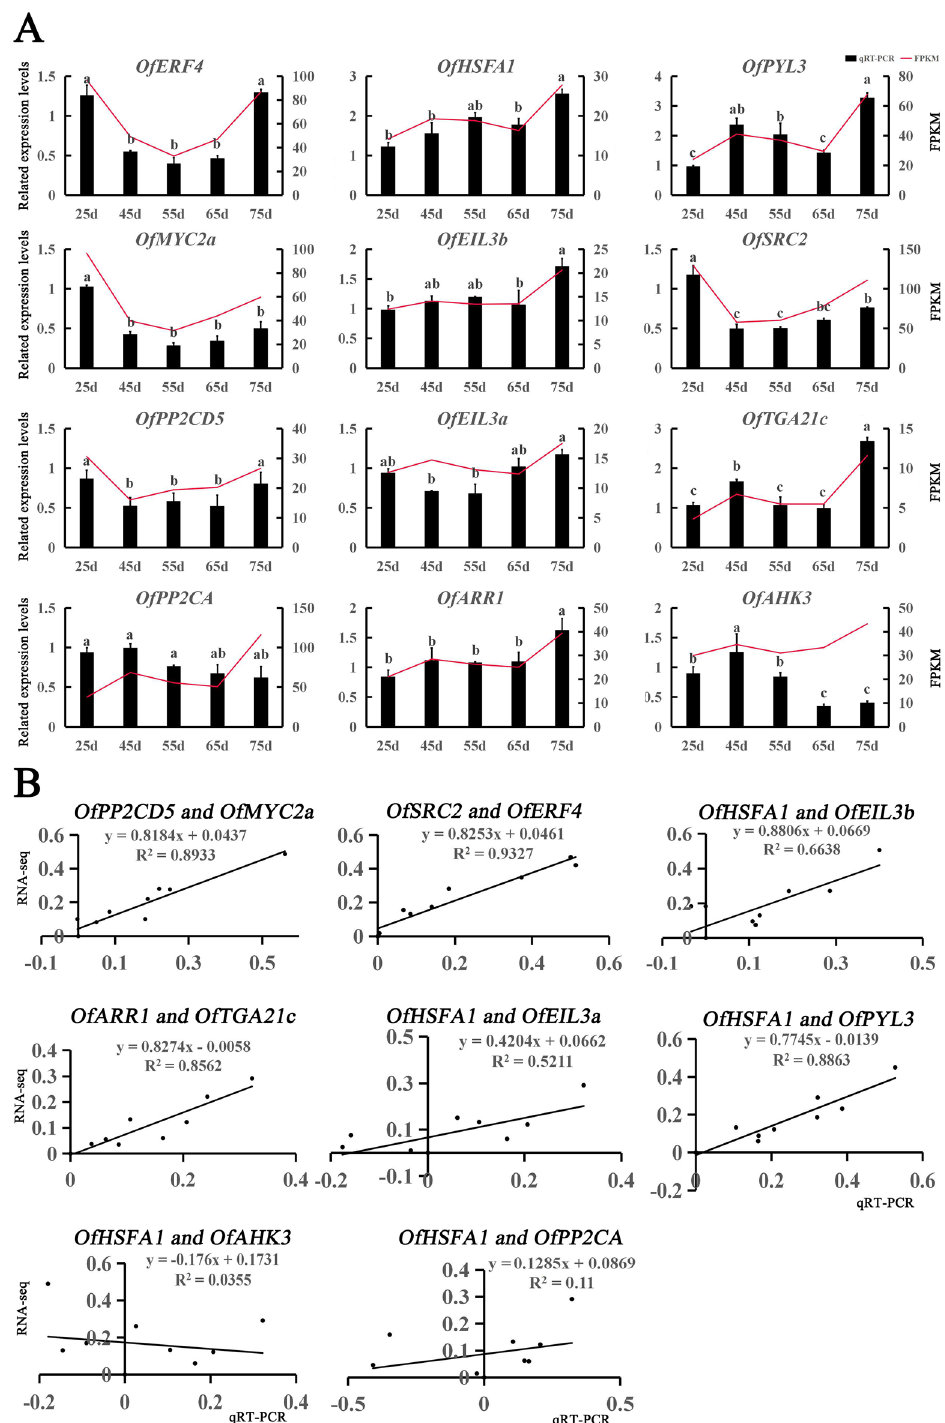
Figure 6. qRT-PCR validation of hub genes and edge genes in feature modules. ( A ) The expression levels of 12 genes (four genes from the ‘royalblue’ module and eight from the ‘brown’ module) and FPKM values. Different letters denote significant differences according to the Tukey’s test ( P < 0.05). ( B ) Correlation coefficient analysis of hub genes and edge genes in feature